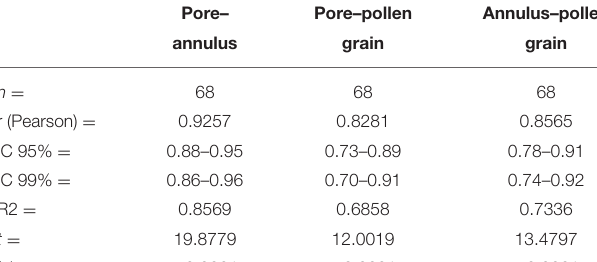
TABLE 5 | Pearson correlation coefficient values showing the strength of relationship among the pore, annulus and size of the pollen grain.